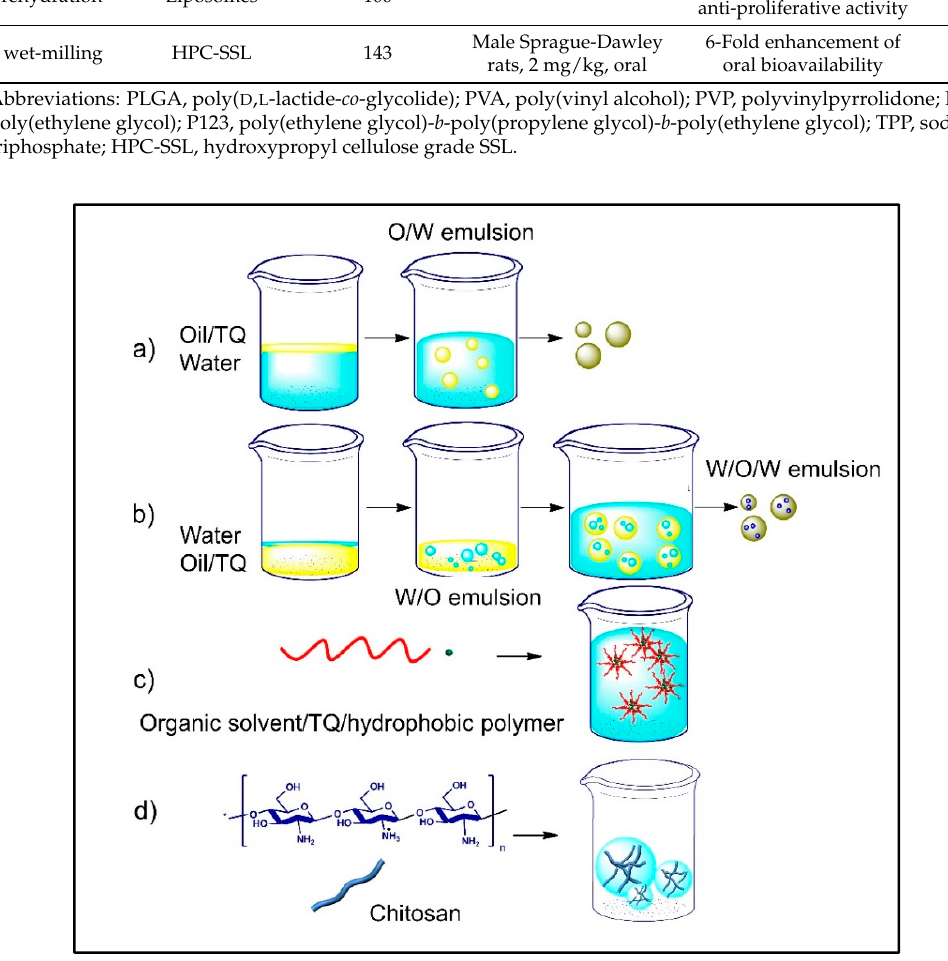
Figure 3. Thymoquinone nanoformulations prepared through ( a ) single emulsion; ( b ) double emulsion; ( c ) nanoprecipitation; ( d ) ionic gelation methods.